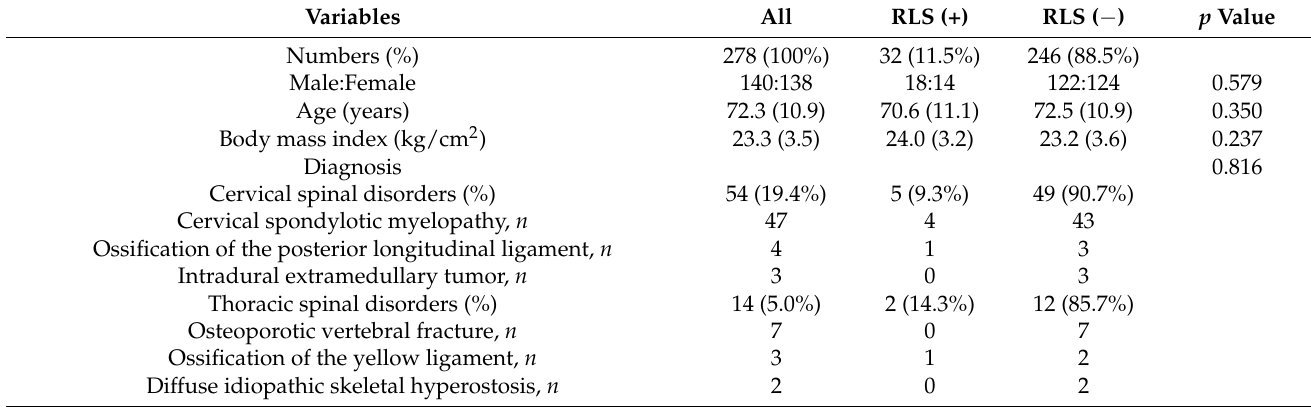
Table 1. Baseline characteristics of 278 outpatients at a single spine center in this study on the prevalence of restless legs syndrome in spinal disorders. RLS —restless legs syndrome, IRLSSG —the international restless legs syndrome study group, HADS —the hospital anxiety and depression scale, HADS-A —HADS anxiety, HADS-D —HADS